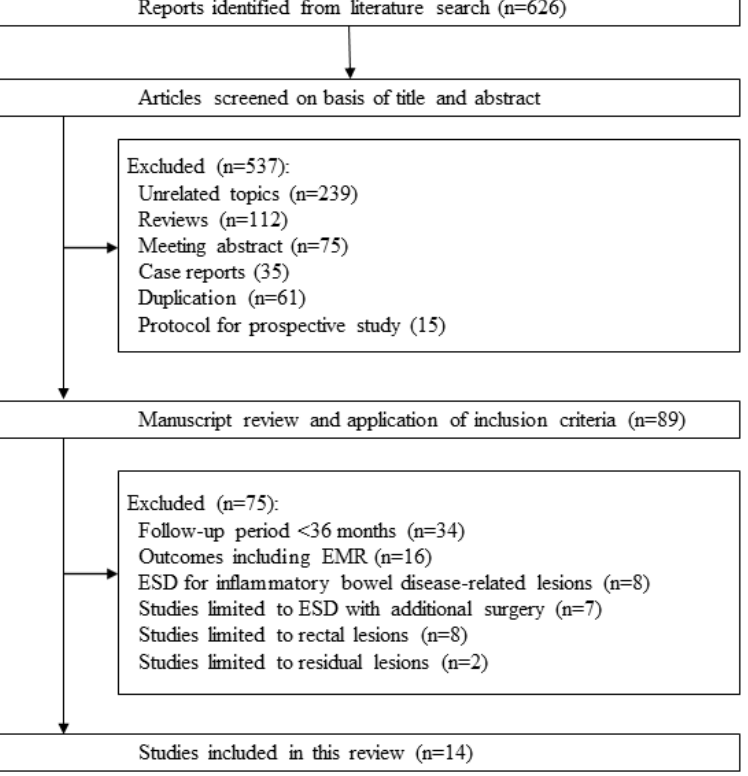
Figure 3. Flow diagram of the systematic literature search.